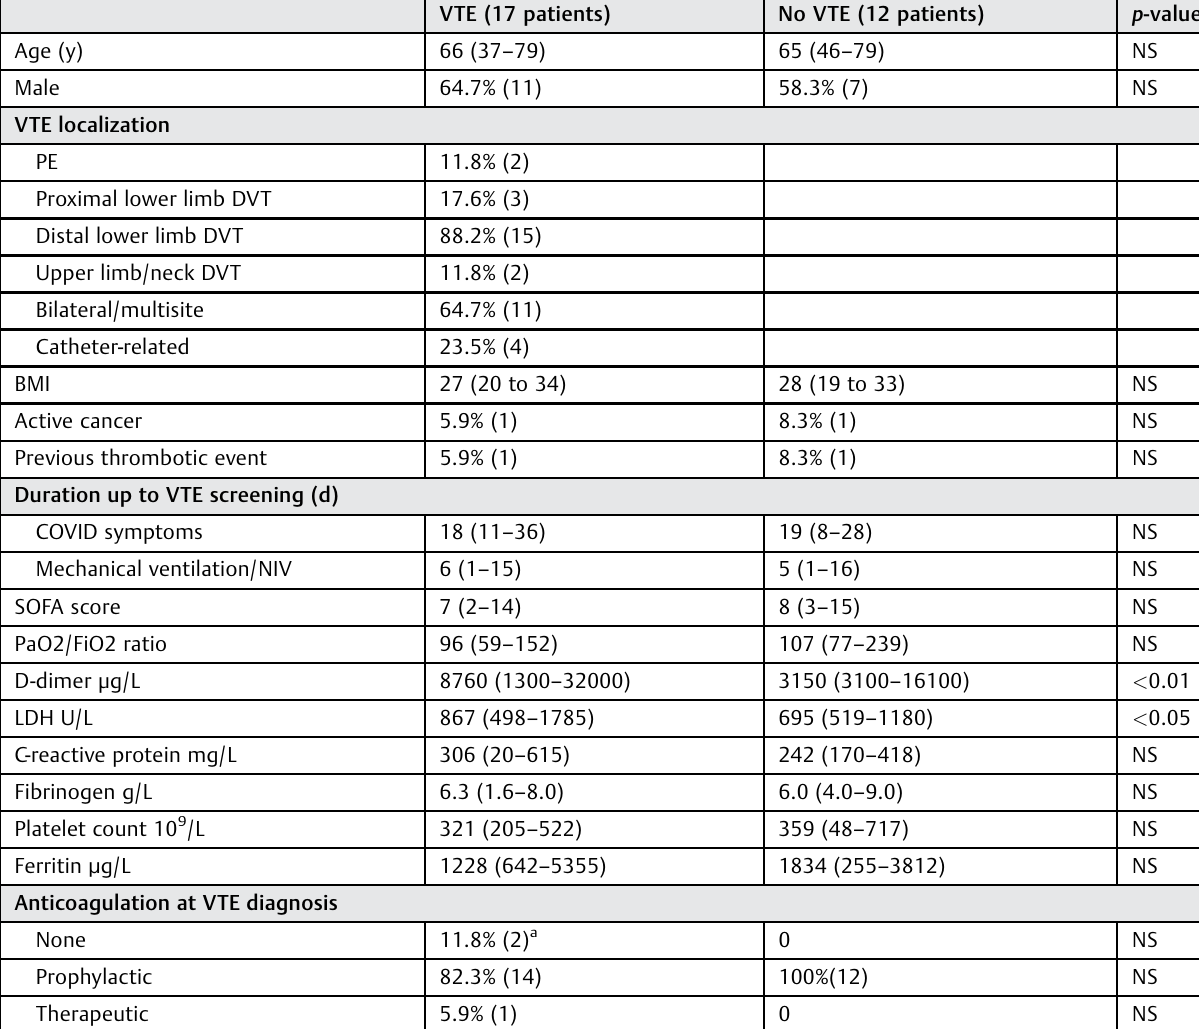
Table 1 Clinical presentation of VTE among the 29 patients with COVID-19 ARDS in the ICU VTE (17